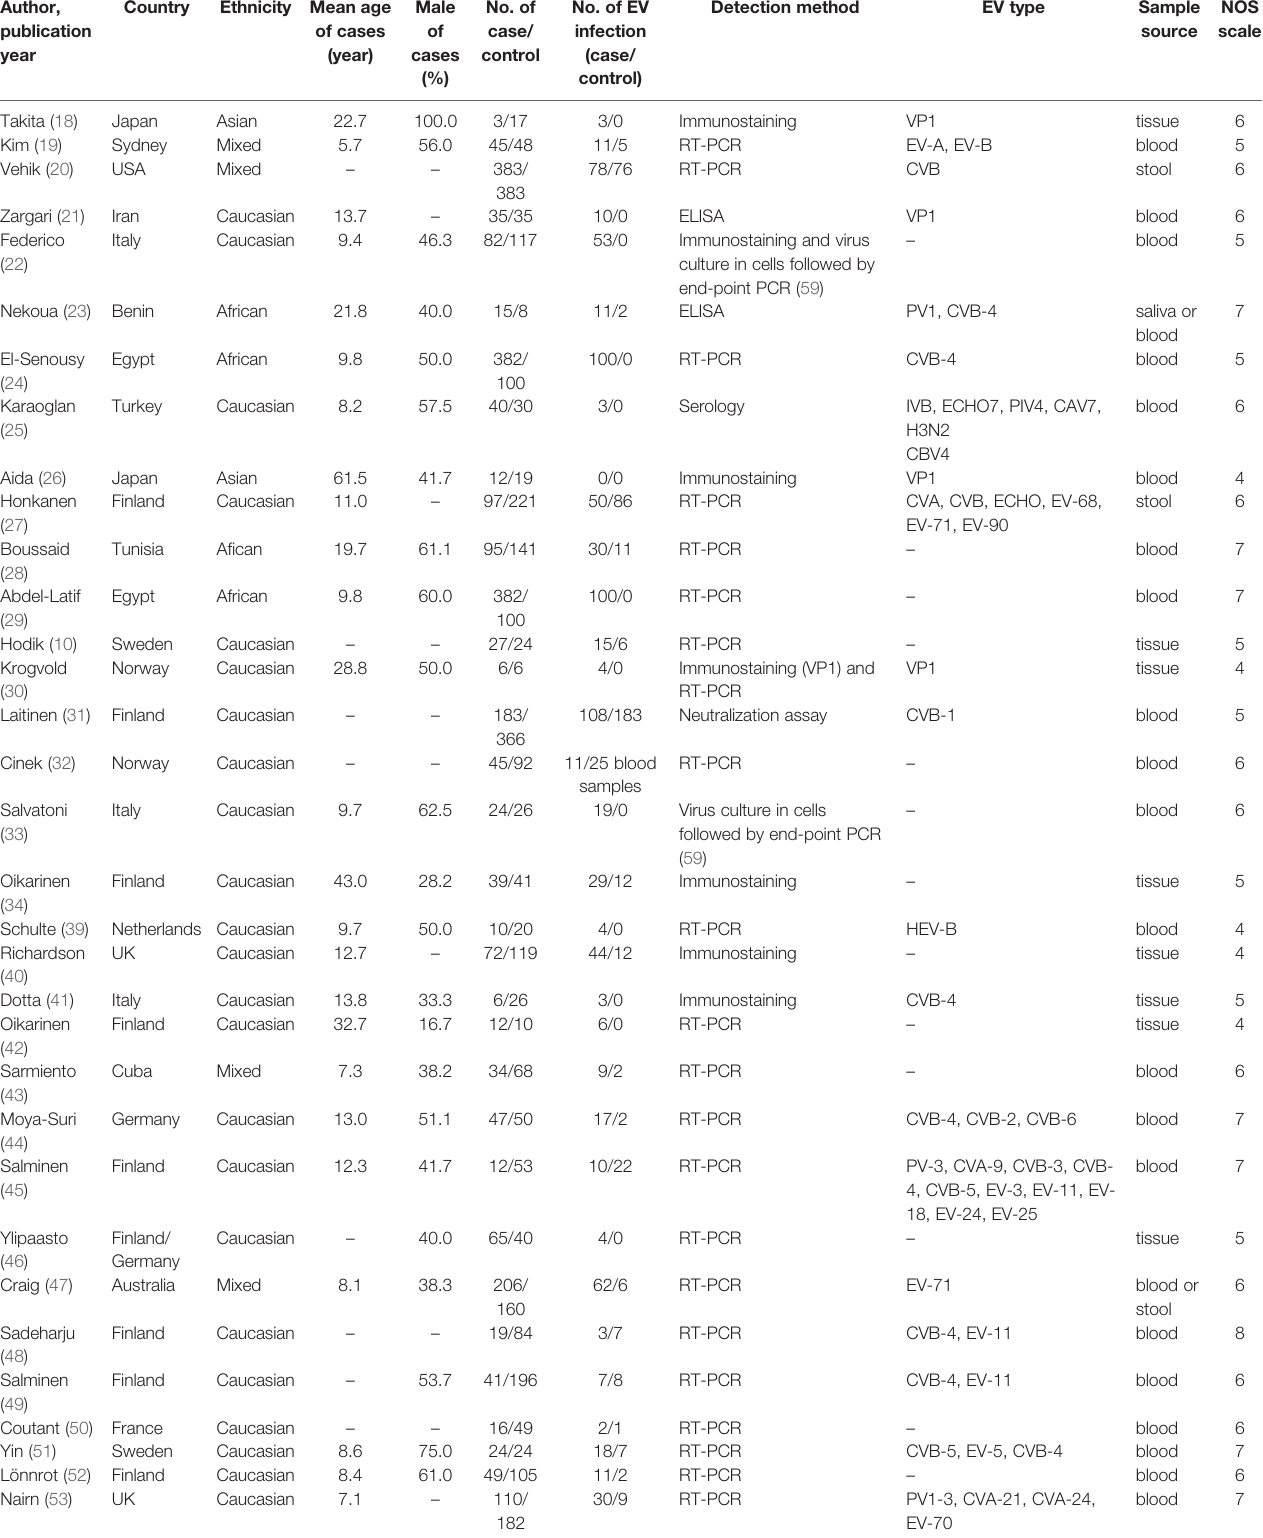
TABLE 1 | Characteristics of the 38 studies included in the present